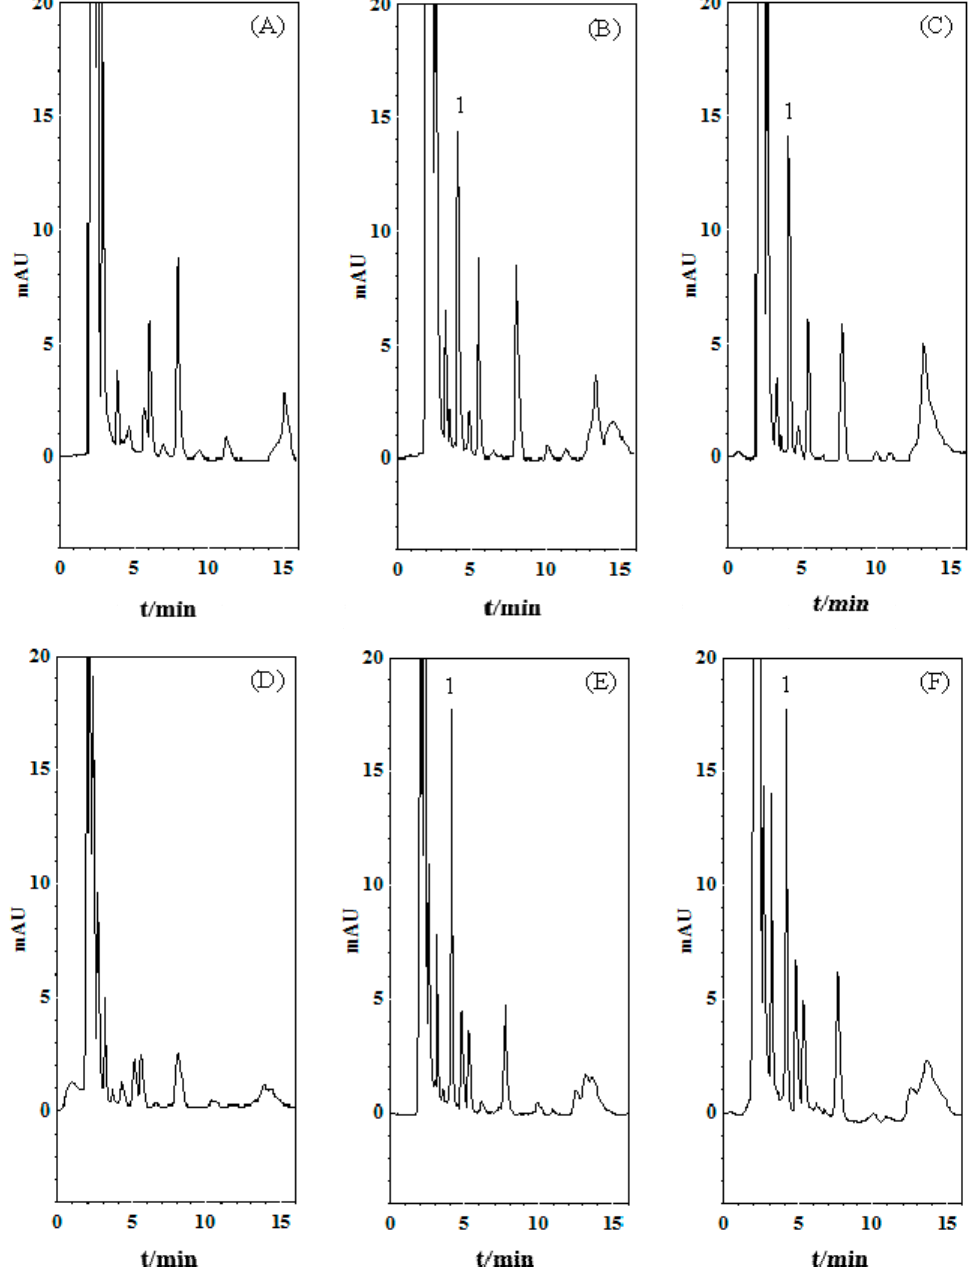
Figure 1. Representative HPLC chromatograms of ( A ) blank blood dialysate; ( B ) blank blood dialysate spiked with maleic acid (1 µg/mL); ( C ) blood dialysate sample containing maleic acid (0.98 µg/mL) collected at 60–75 min after maleic acid administration (30 mg/kg, i.v.); ( D ) blank kidney dialysate; ( E ) blank kidney dialysate spiked with maleic acid (1 µg/mL) and ( F ) kidney dialysate sample containing maleic acid (1.20 µg/mL) collected at 105–120 min after maleic acid administration (30 mg/kg, i.v.). 1: maleic acid.